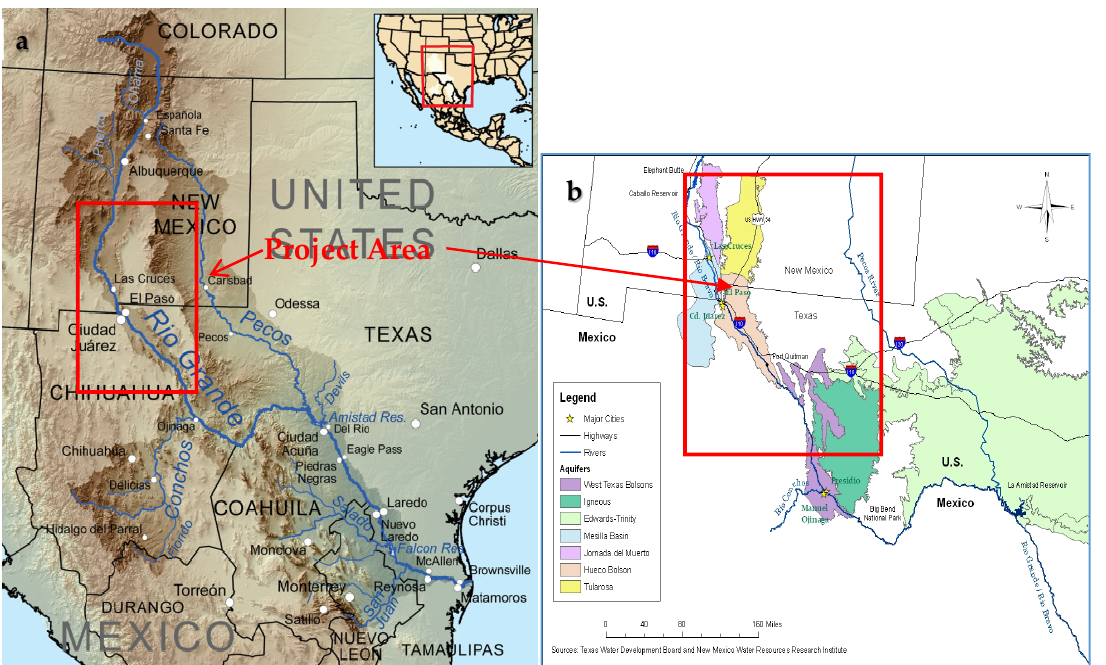
Figure 1. Water resources of the Paso del Norte region. ( a ) Rio Grande Basin showing the project area, the Middle Rio Grande; ( b ) Regional groundwater resources.